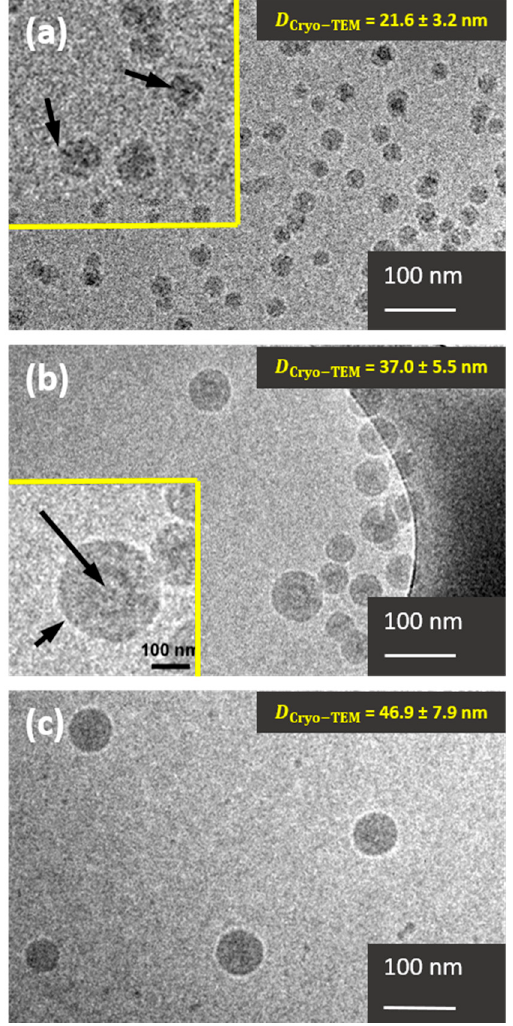
Figure 5. ( a ) Cryo-TEM image of PHEA 85 – b –PS 130 particles. Particle surface displays some dark spots, better seen in the inset. Indicated by arrows, these spots correspond to PHEA chains pointing parallel to the electron beam trough the continuous phase. ( b ) Cryo-TEM image of the PHEA 23 – b –PS 130 particles. Two particle morphologies can be distinguished: spherical particles and vesicles. The inset shows the vesicle. The darker rim corresponds to the PHEA chains (short arrow), then the light grey the PS, and finally, again, a darker thin rim for the PHEA chains in contact with the inner space (long arrow). ( c ) Pure PS nanoparticles.